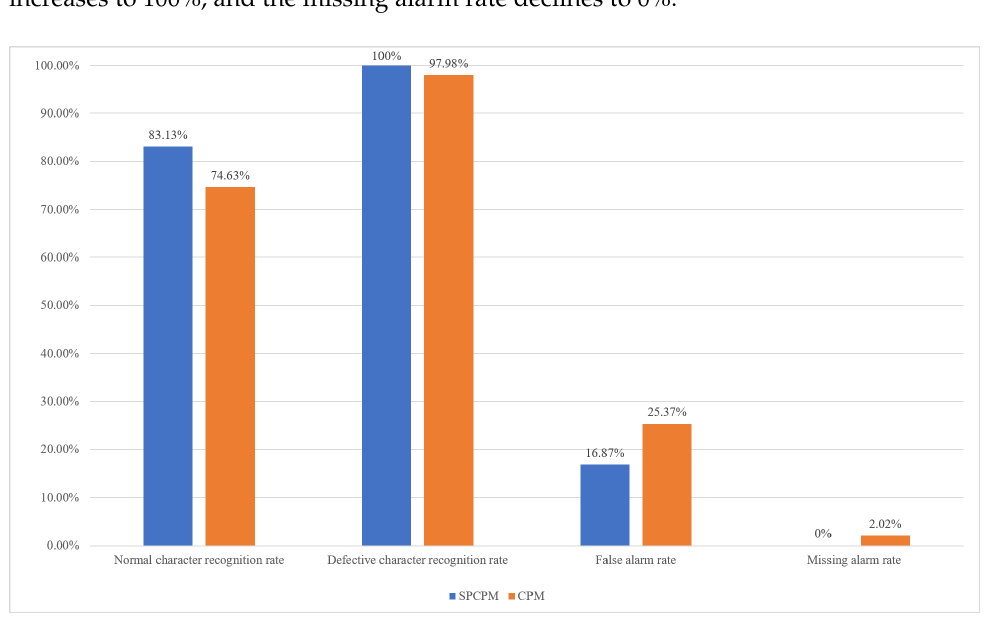
Figure 22. Comparison results between SPCPM and CPM